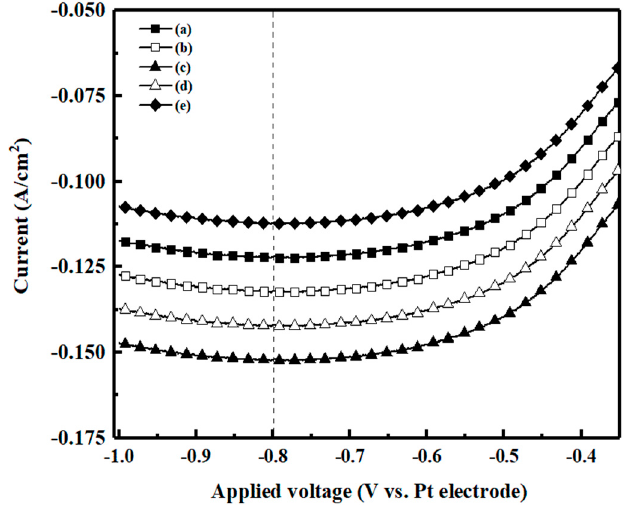
Figure 7. LSV results of the Mn-Ni-O electrodes. Samples (a), (b), (c), (d) and (e) denote the samples with electroplating Mn:Ni ratio of 1:0, 1:0.25, 1:0.67, 1:4, and 0:1 respectively.